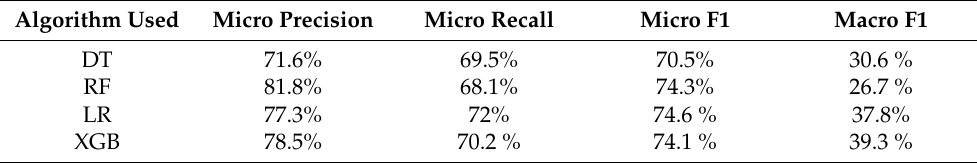
Table 4. Experiment results obtained at the second classification stage. Algorithm